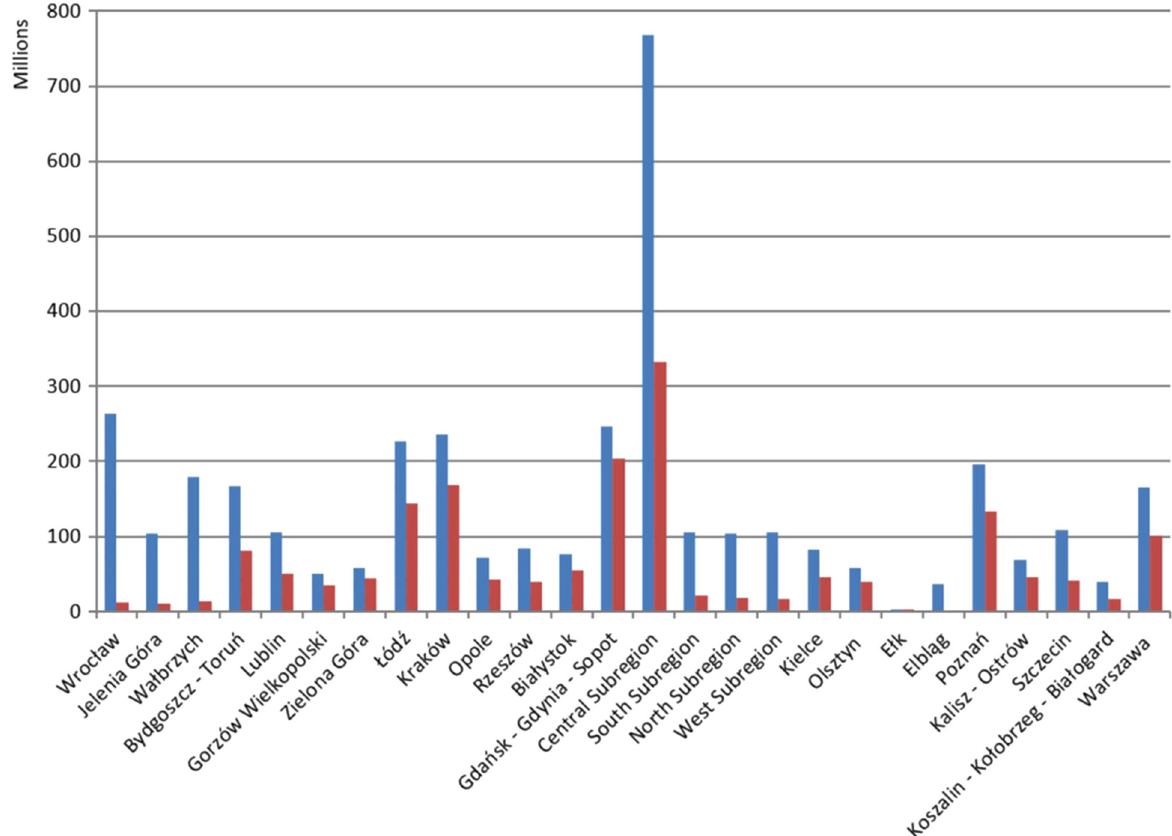
Fig. 4. Allocation for ITIs under ROPs (blue colour) and resources contracted by the end of May 2018 (red colour) (in million EUR), state as of May